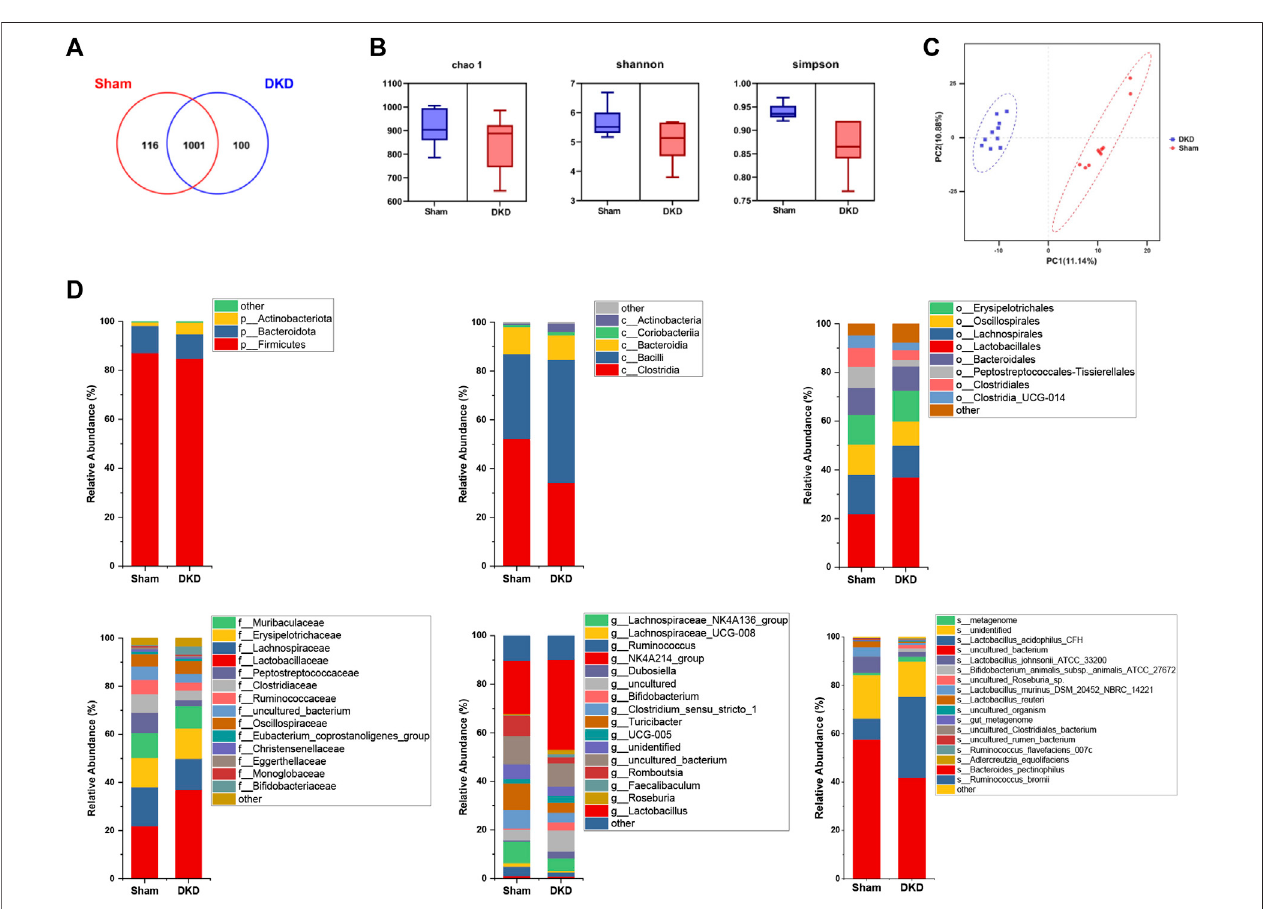
FIGURE 5 | Altered bacterial taxa in DKD rats. (A) Venn diagram of OTU distribution between samples from sham and DKD rats. (B) Alpha-diversity indices of Chao1, Shannon, and Simpson of gut microbiota between sham and DKD rats. (C) PLS-DA of gut bacterial communities from the sham and DKD groups. (D) Taxonomic distributions of bacteria from colon content 16S rDNA sequencing data at the phylum to genus level between sham and DKD rats.